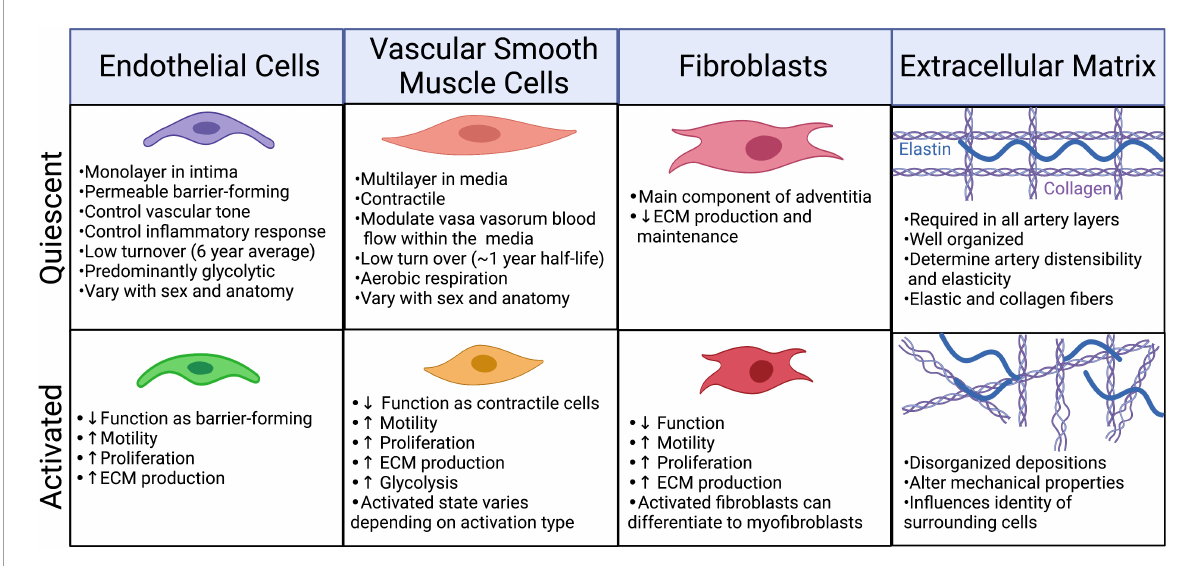
FIGURE3 Phenotypic changes in the cellular and extracellular components of the artery in response to injury/infection. Created with